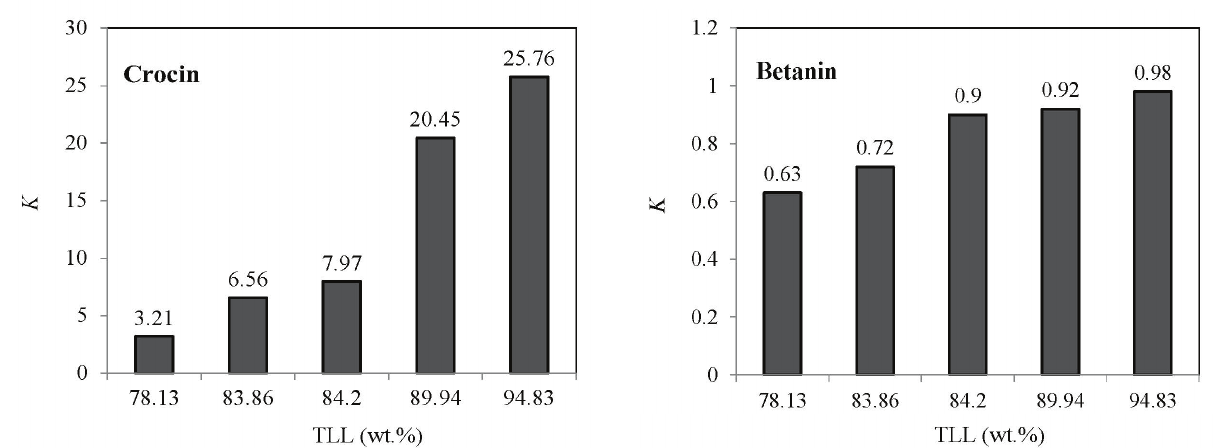
Fig. 1 – Effect of tie-line length (TLL) on partition coefficient (K) crocin / betanin of the ATPS containing sorbitol + [P Sorbitol + H O at 298 2